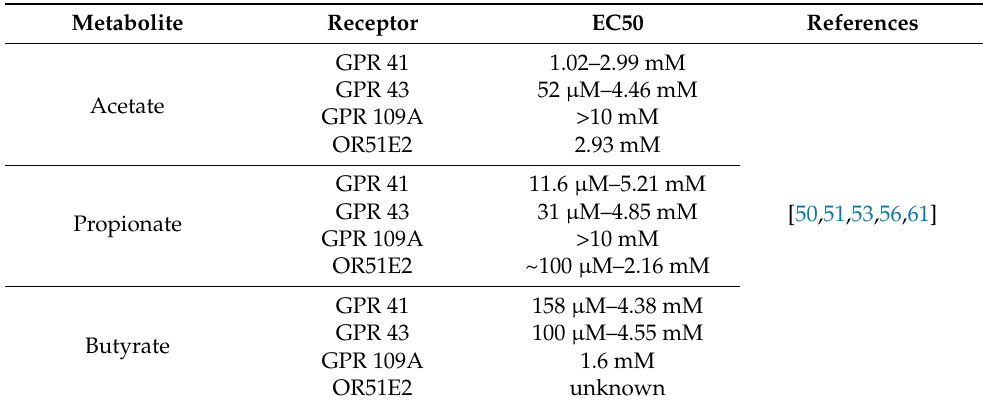
Table 2. Receptors for main SCFAs, showing half maximal effective concentrations (EC50) obtained using different cell lines with appropriate transfected